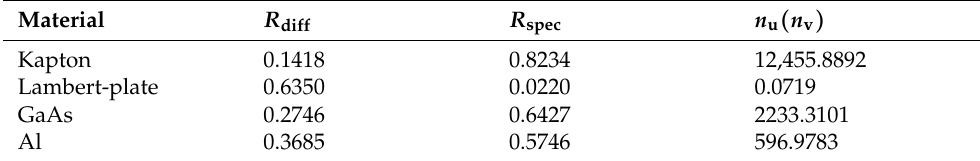
Table 4. Traditional Phong model parameters of some surface material of space debris